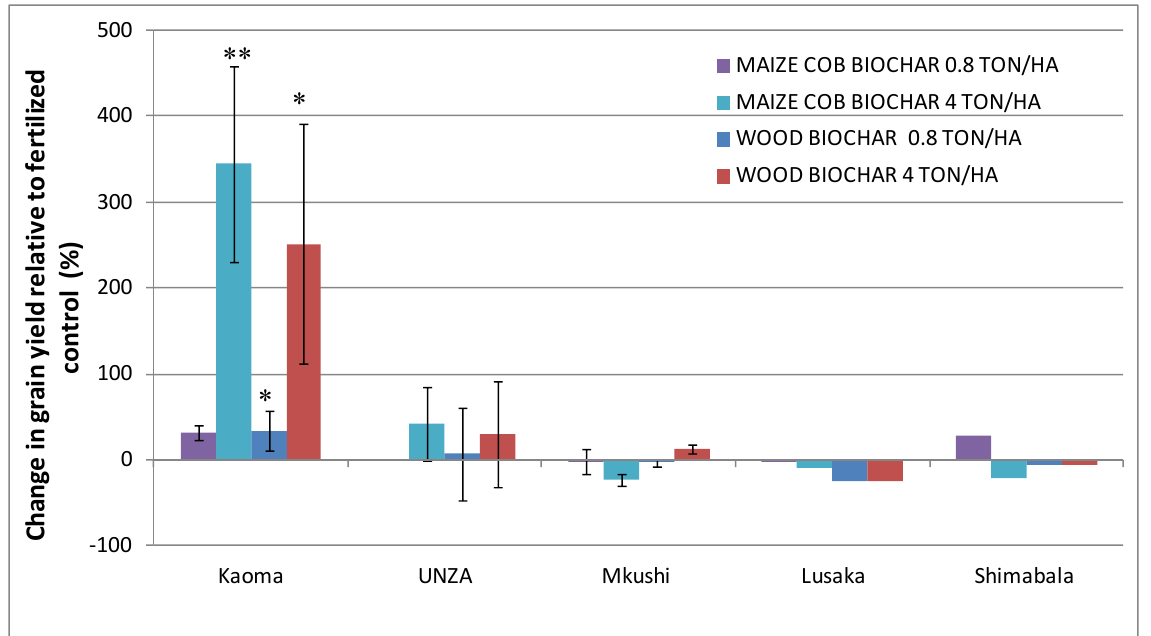
Figure 1. Change in grain yield as a percentage of the fertilized control yield at each site (absolute yield numbers are in Table 2). A change of 100% thus implies a doubling of harvest yield. Error bars in Kaoma and Mkushi represent standard deviations of average measurements for the seasons 2010–2011 and 2011–2012. Error bars for UNZA represent standard deviations in four blocks in season 2010–2011. No replicates for Shimabala and Lusaka were carried out. Individual numbers for seasons 2011 and 2012 for Kaoma